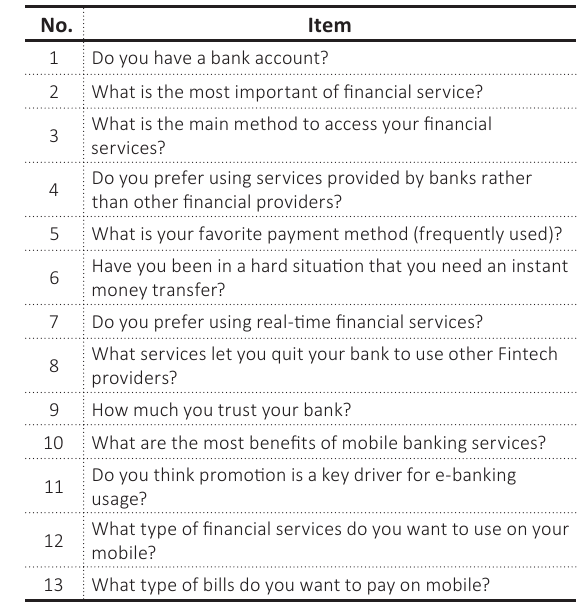
Table 1. Respondent’s financial behavior (study instrument